Question: What kind of plot is shown here?
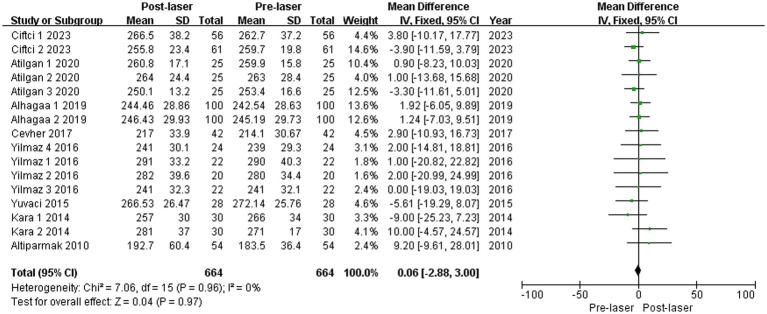
Answer: forest